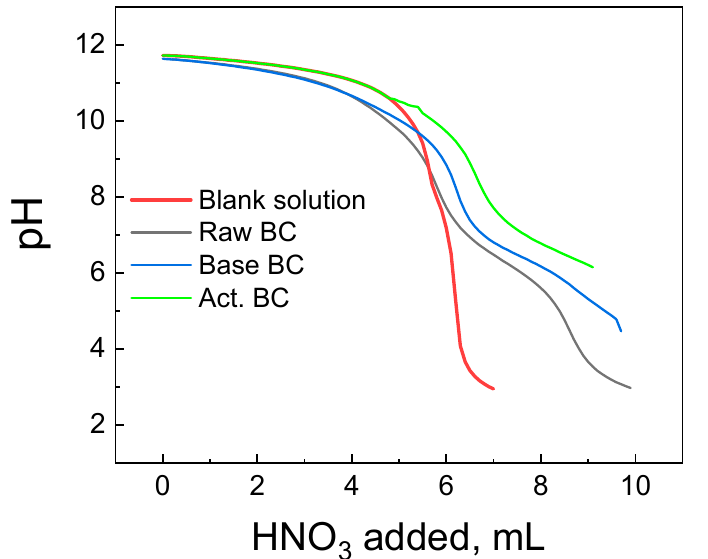
Figure 6. Potentiometric titration curves of the biochar’s studied and the corresponding blank solution.